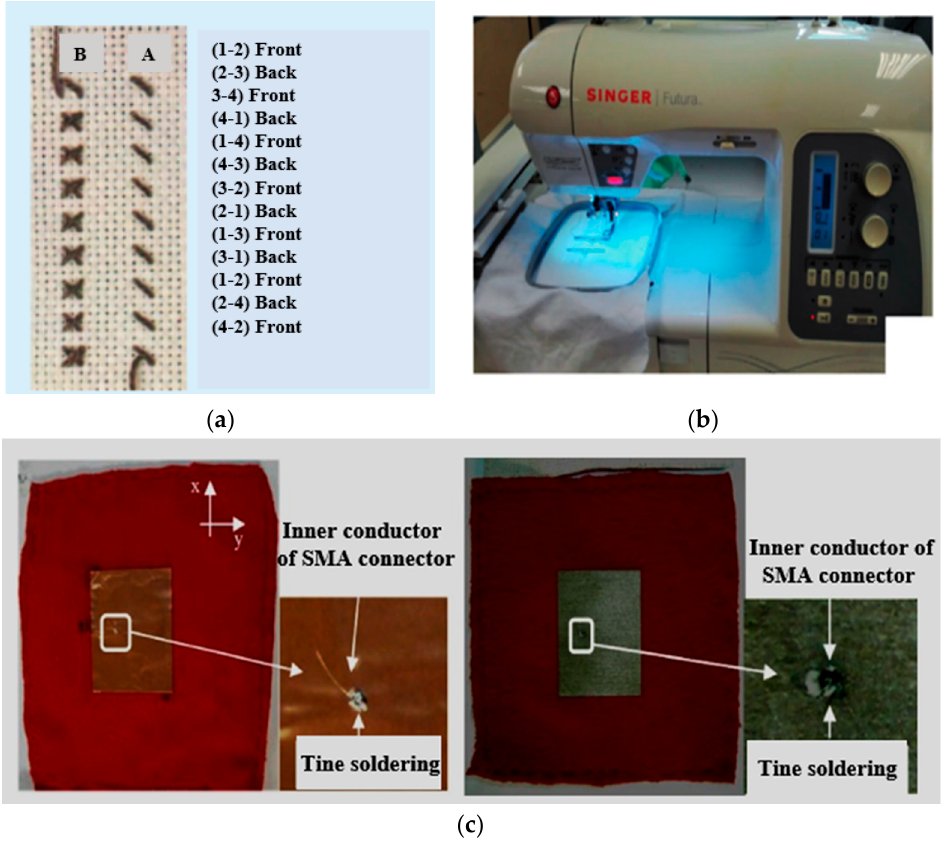
Figure 6. ( a ) Fabric used to realize the patch employing conducting threads and subscripts “back” and “front” of the fabric [211], ( b ) embroidery machine [213], and ( c ) adhesive copper tape (adhesive conductive fabric) [211]. Table 7. Comparison of fabric and adhesive techniques [221].